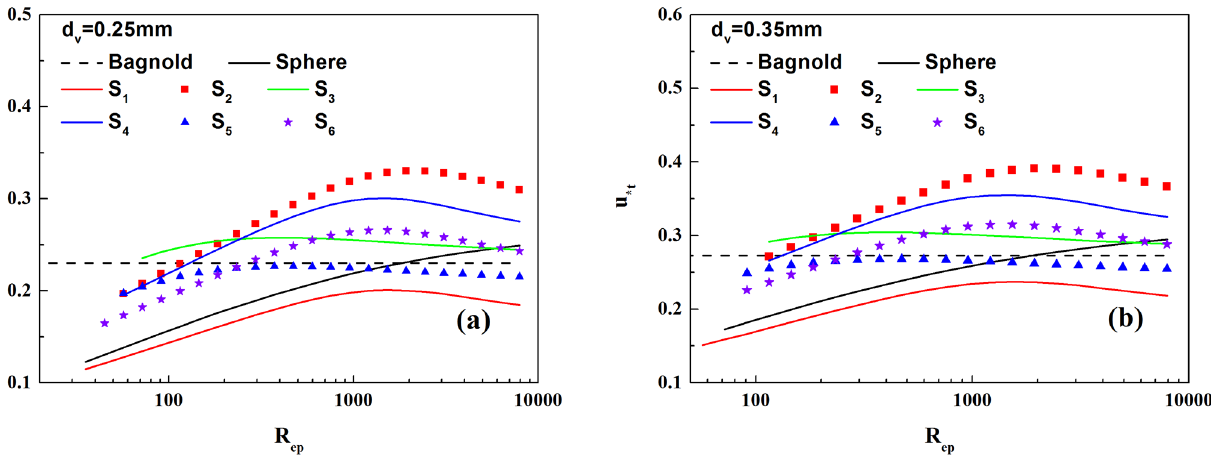
Figure 3. The critical starting friction wind velocity for sand grains of different shape. (a). Comparison of the critical starting friction wind velocity of non-spherical particles with that of spherical particles (equivalent diameter d v ~ 0 : 25 mm ). (b). Comparison of the critical starting friction wind velocity of non-spherical particles with that of spherical particles (equivalent diameter d v ~ 0 : 35 mm ). The black solid line indicates the spherical sand grains, S 1 and S 2 represent two different ellipsoid-shaped sand particles, S 3 represents cube-shaped sand particles, S 4 and S 5 are two types of cylinder-shaped sand particles, and S 6 represents frustum-shaped sand particles.